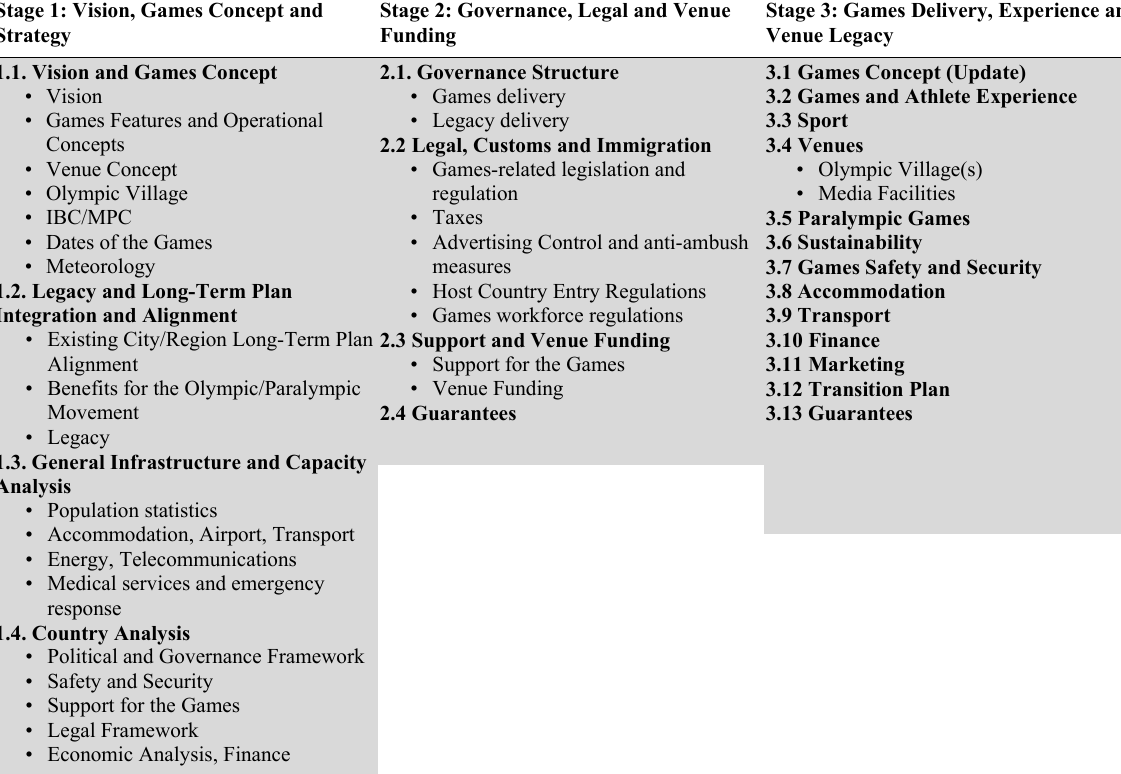
Evaluation Criteria for Selection of Host City Stage 1: Vision, Games Concept and